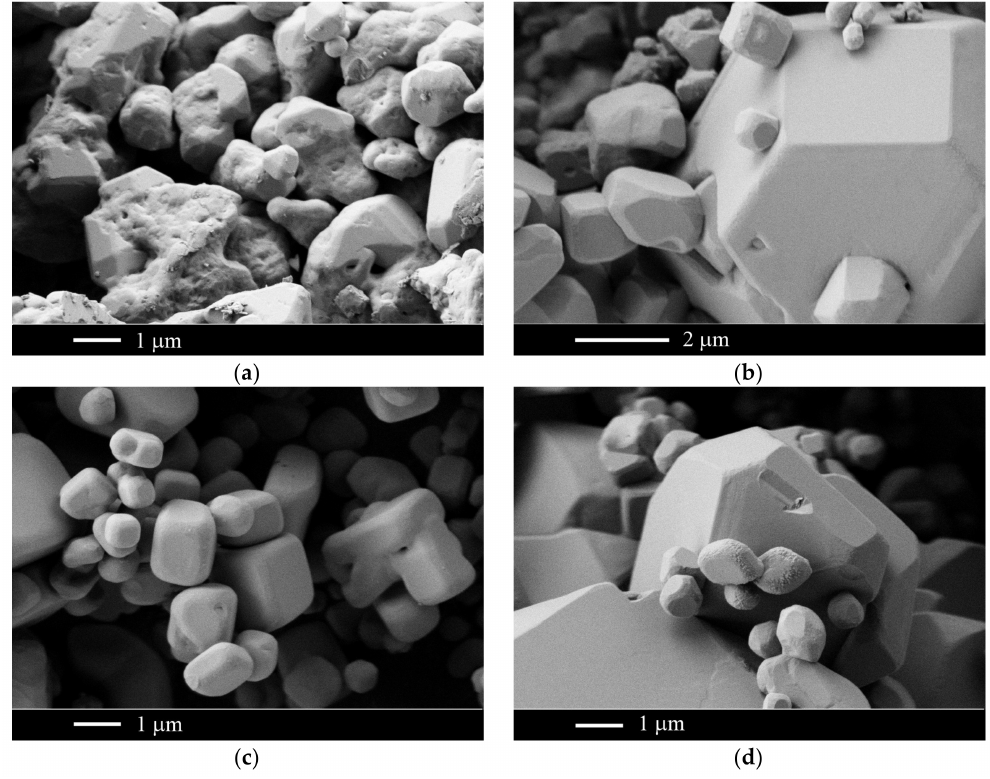
Figure 8. SEM images of CaF 2 , sample 10 ( a ) and SrF 2 samples 15 ( b ), 14 ( c ), 15 ( d